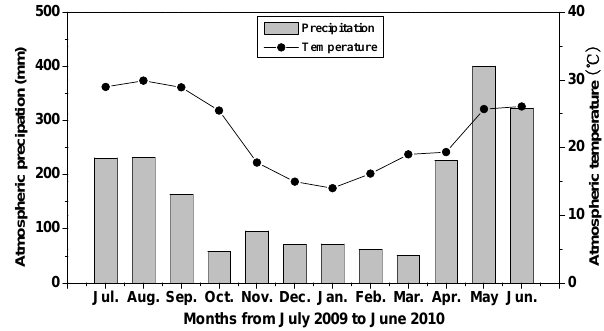
Fig. A1. Monthly precipitation and monthly mean air temperature